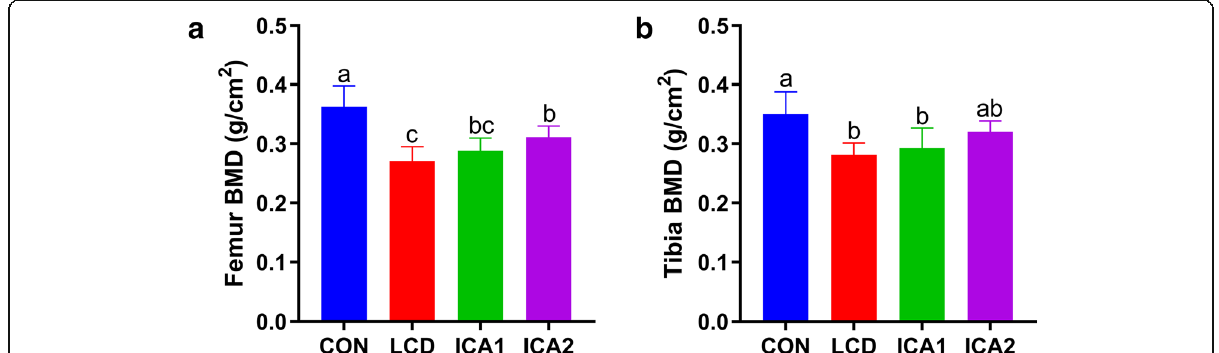
Fig. 1 Effects of ICA supplementation on bone mineral density (BMD) of femur and tibia. a Femur BMD and b tibia BMD. ICA, icariin. CON, basal diet. LCD, low calcium diet. ICA1, low calcium diet supplied with 0.5 g/kg ICA. ICA2, low calcium diet supplied with 2.0 g/kg ICA. Data are presented as the mean ± SD ( n = 6). Means in each column with different alphabetic letters are significantly ( P < 0.05) different